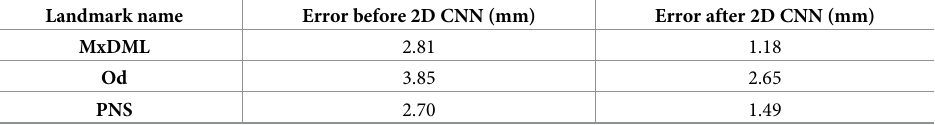
Table 3. Error evaluation of the landmarks on the midsagittal plane. Initial error and 2D CNN error are presented in the table. The errors are reduced after the 2D CNN is